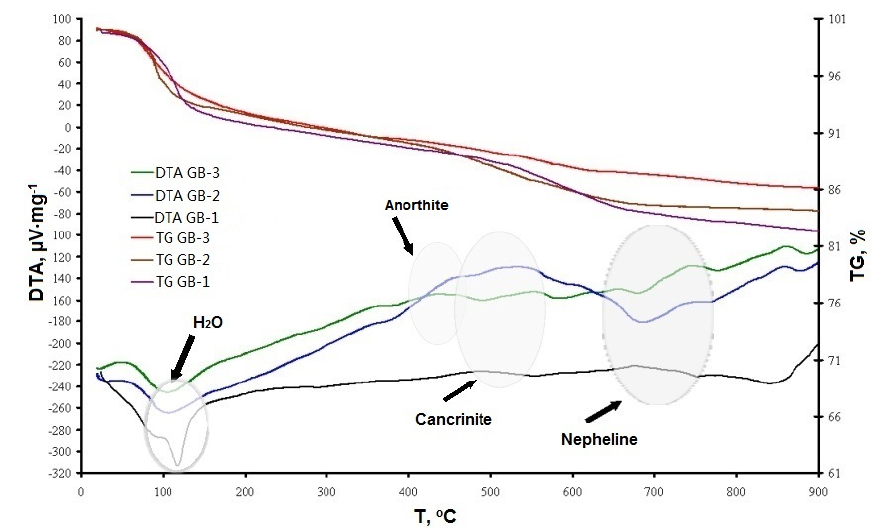
Figure 5. Thermogravimetric analysis of alkali-activated compositions.